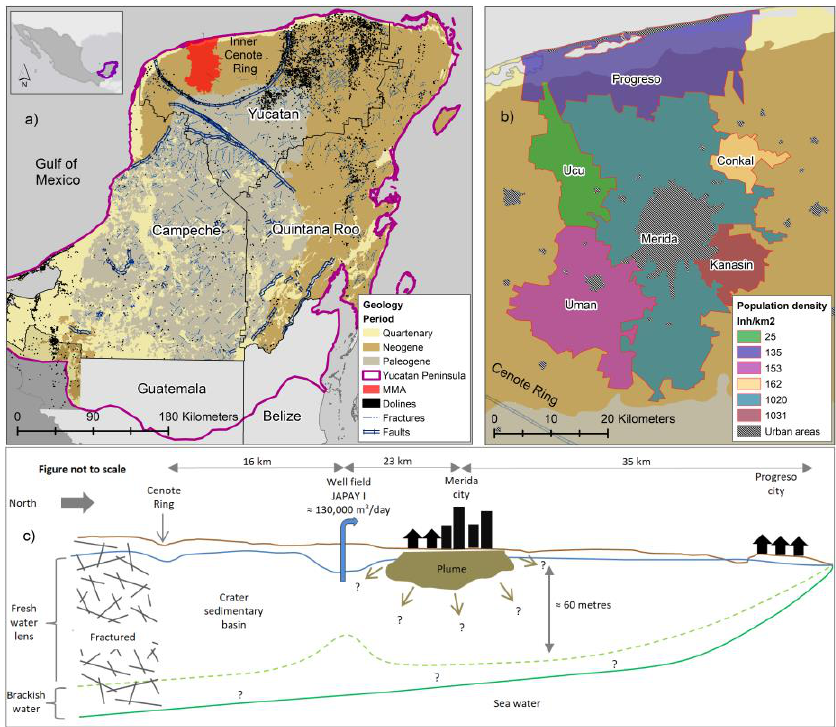
Figure 1. General characteristics of the study area; ( a ) extension of the Yucatan Peninsula and main karst features; ( b ) municipalities composing the MMA, and ( c ) a basic hydrogeological representation of the Merida city sub-surface (modified from Marín [4]).